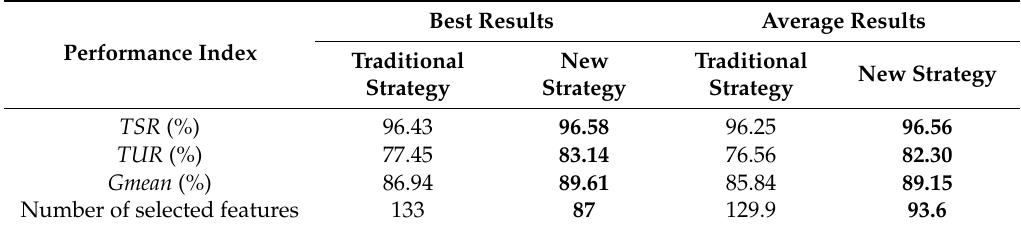
Table 6. Comparison of the results of different particle encoding strategies.